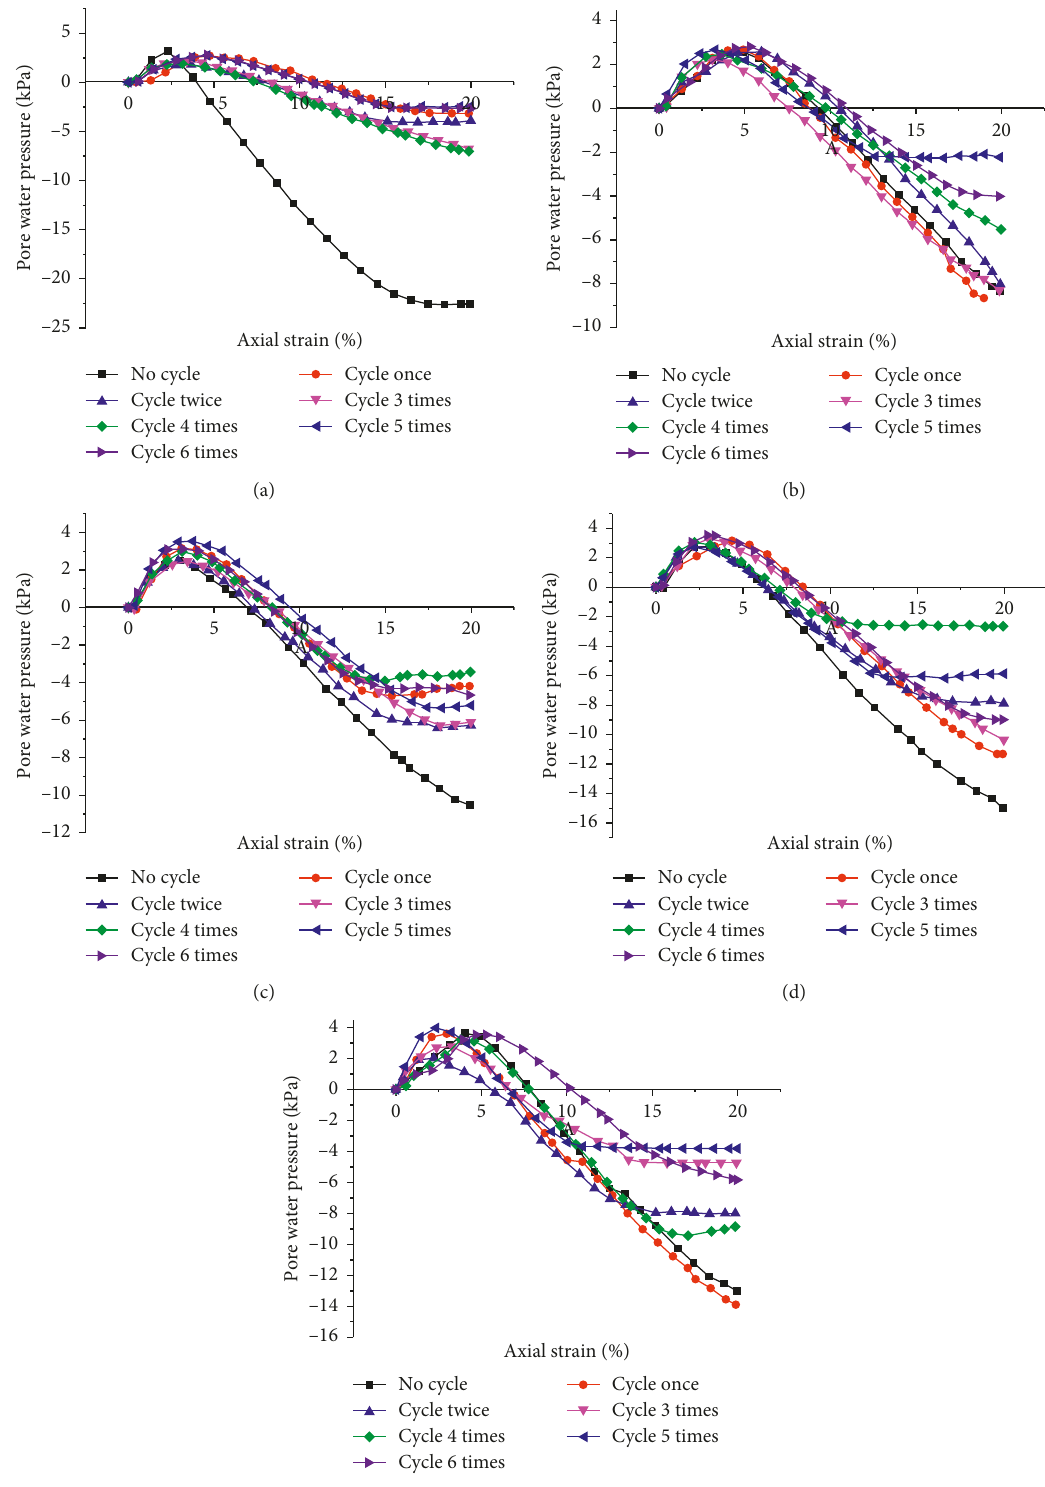
Figure 7: Changes in pore pressure of various moisture content samples at natural dry density under different times of moisture absorption and desorption cycles. Water content: (a) 6.10%, (b) 10.40%, (c) 14.00%, (d) 18.20%, and (e)